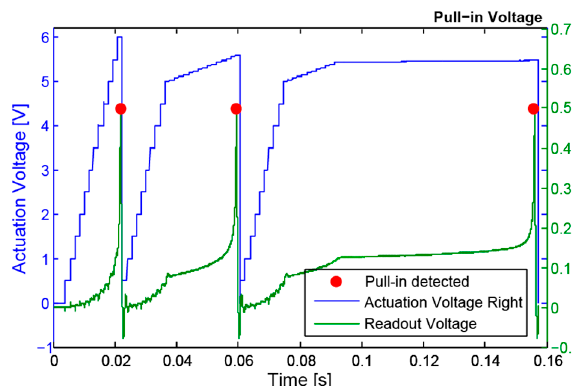
Figure 5. Pull-in ramp with highlighted detection points. The immediate actuation voltage removal is evident to avoid hitting the counter electrodes.